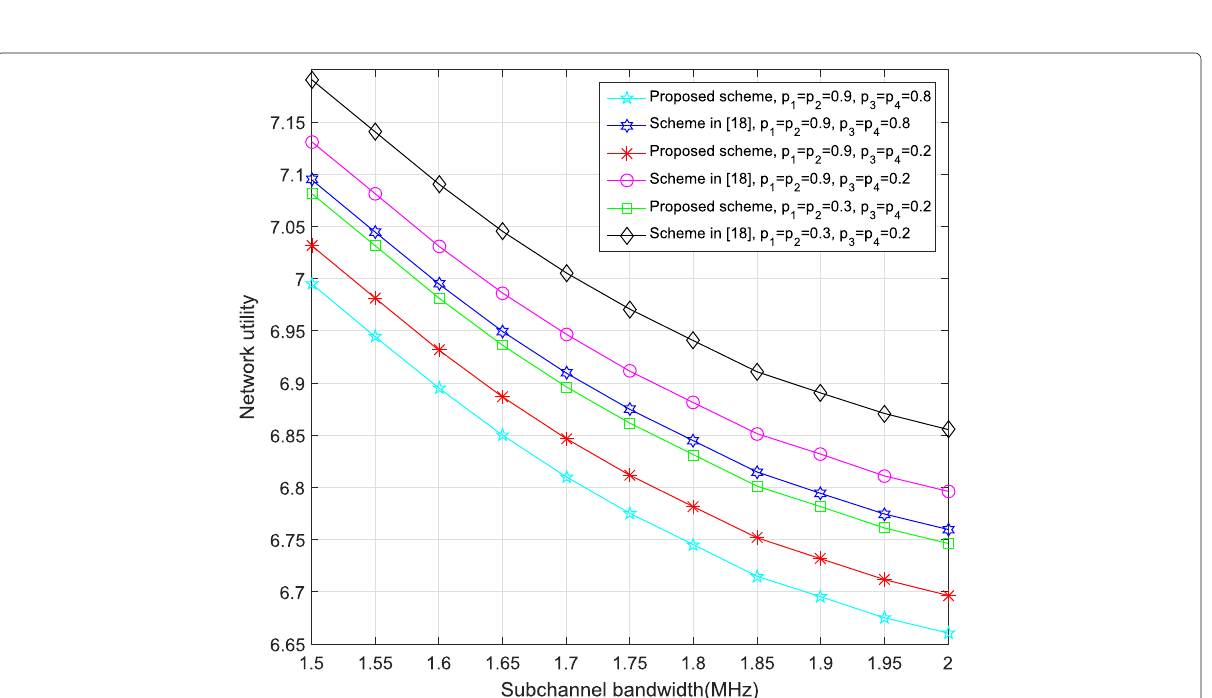
Fig. 5 Network utility versus subchannel bandwidth (different transmission power of GAPs). The network utility of the system versus the subchannel bandwidth for different transmission power of